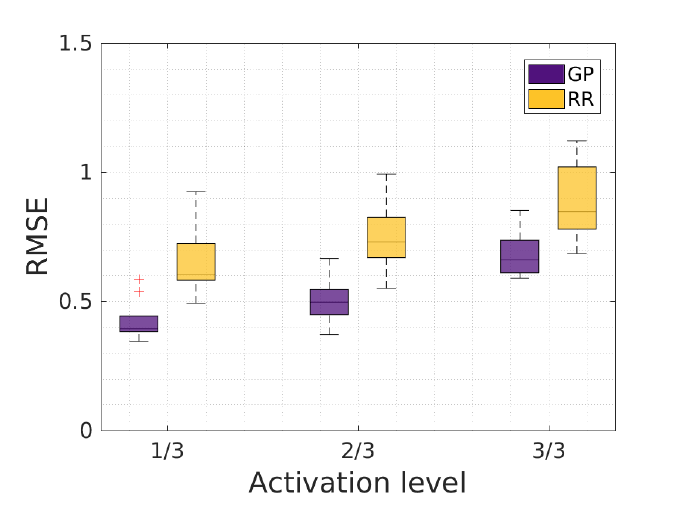
Figure 9. Comparison of the root-mean-square error (RMSE) between Gaussian process regression (GPR) and ridge regression (RR) for different activation levels.